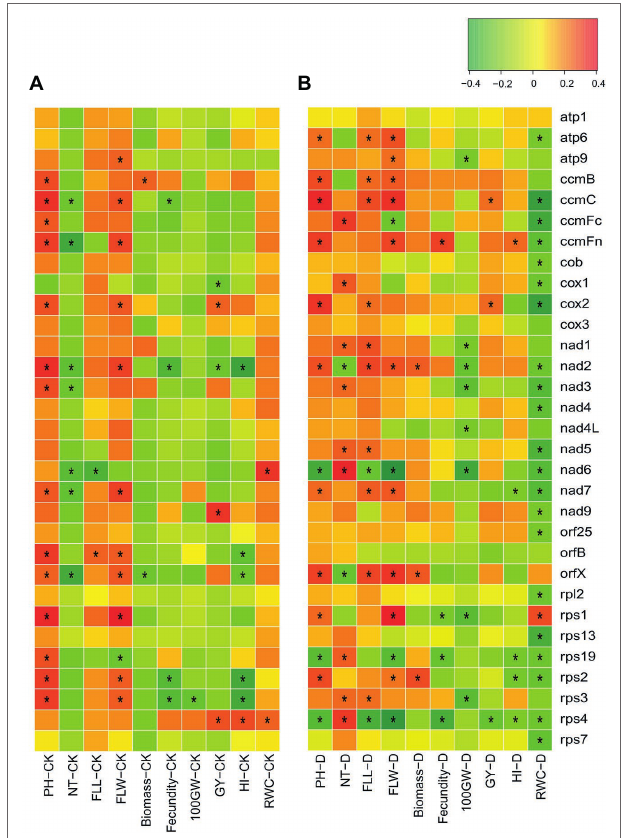
FIGURE 2 | Correlation between RNA editing efficiencies of a mitochondrial gene and a measured trait in (A) well-watered (CK) and (B) drought-treated (D) fields. * indicates the significant correlation (|PCC| > 0.20 and p < 0.05). PH, plant height; NT, number of tillers; FLL, flag leaf length; FLW, flag leaf length, 100GW, 100-grain weight; GY, grain yield per plant; HI, harvest index; RWC, relative water